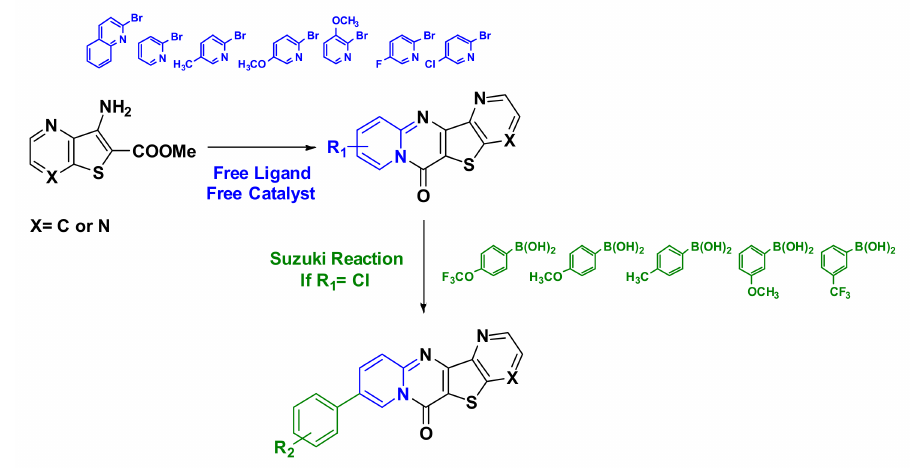
Figure 1. Metal free synthesis of several new tetracyclic compounds from 3-aminothieno[3,2- b ]pyridine-2-carboxylate.